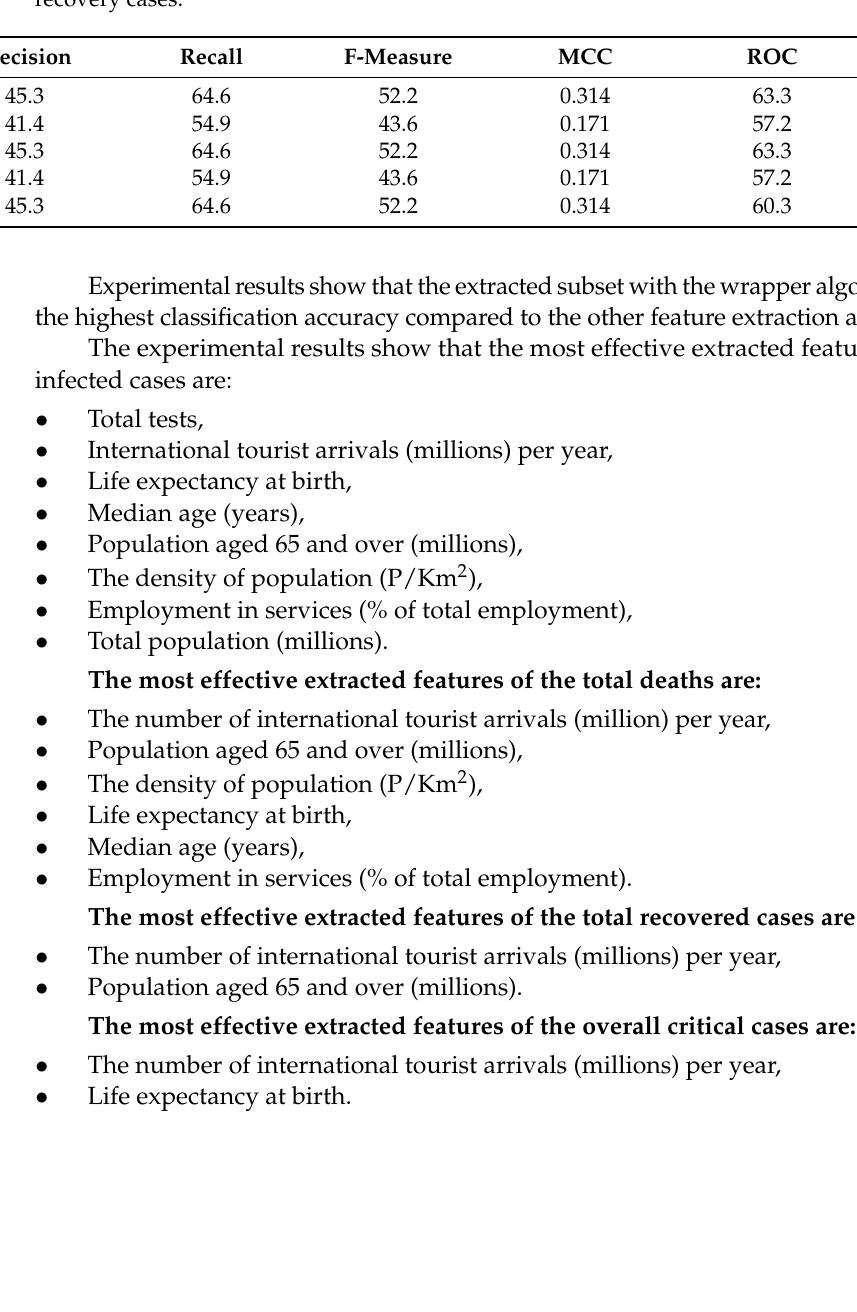
Table 18. Comparison among feature extraction algorithms using SVM classifier to predict the total recovery